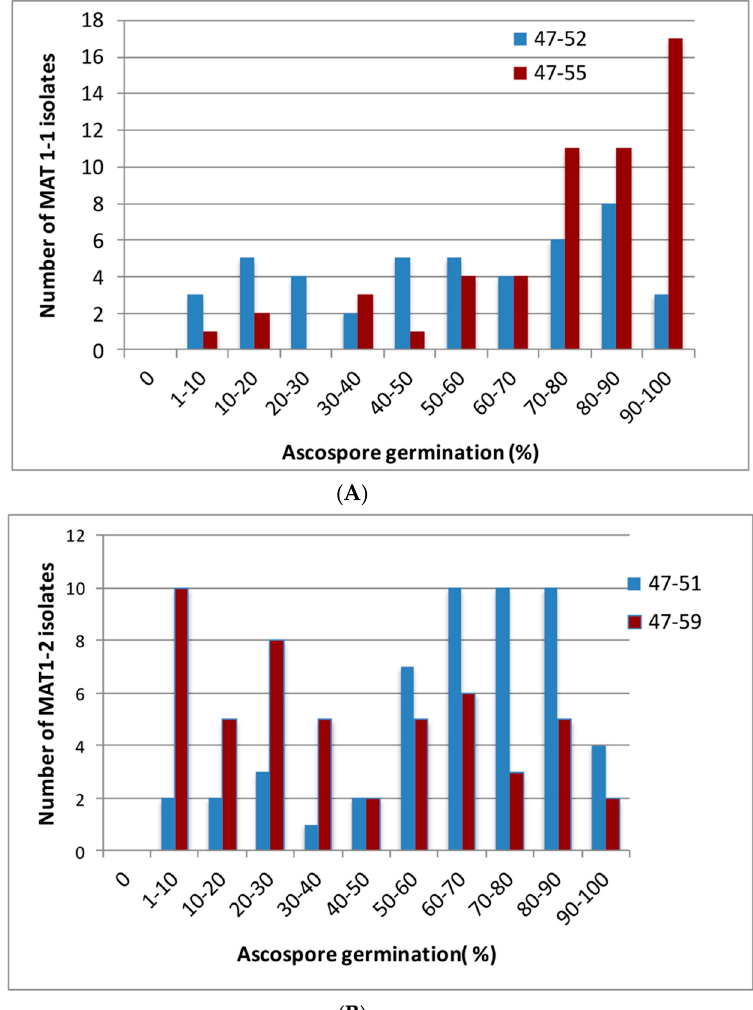
Figure 4. Variation in ascospore germination rate from crosses between different worldwide isolates of A. fumigatus and Irish tester strains. ( A ) Germination rates of ascospores produced when MAT1-1 global isolates were crossed to two MAT1-2 Irish tester strains (47-52 and 47-55). ( B ) Germination rates of ascospores produced when MAT1-2 global isolates were crossed to two MAT1-1 Irish tester strains (47-51 and 47-59). Left hand axis shows the number of isolates producing the bands of rates (1–10%, 10–20% etc.) of ascospore germination shown on axis below.